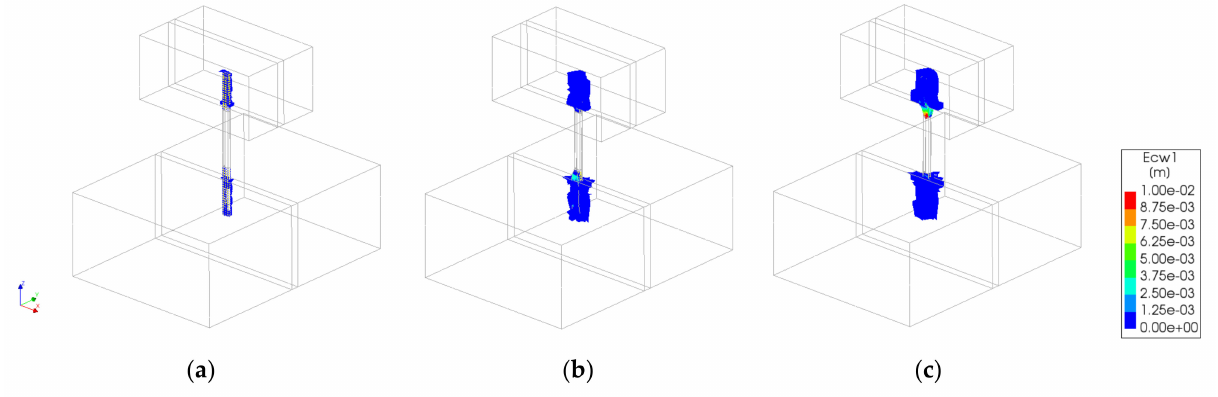
Figure 10. Damage evolution during the analysis of the complete assemblage in tension (crack width in m). ( a ) d = 1 mm; ( b ) d = 5 mm; ( c ) d = 10